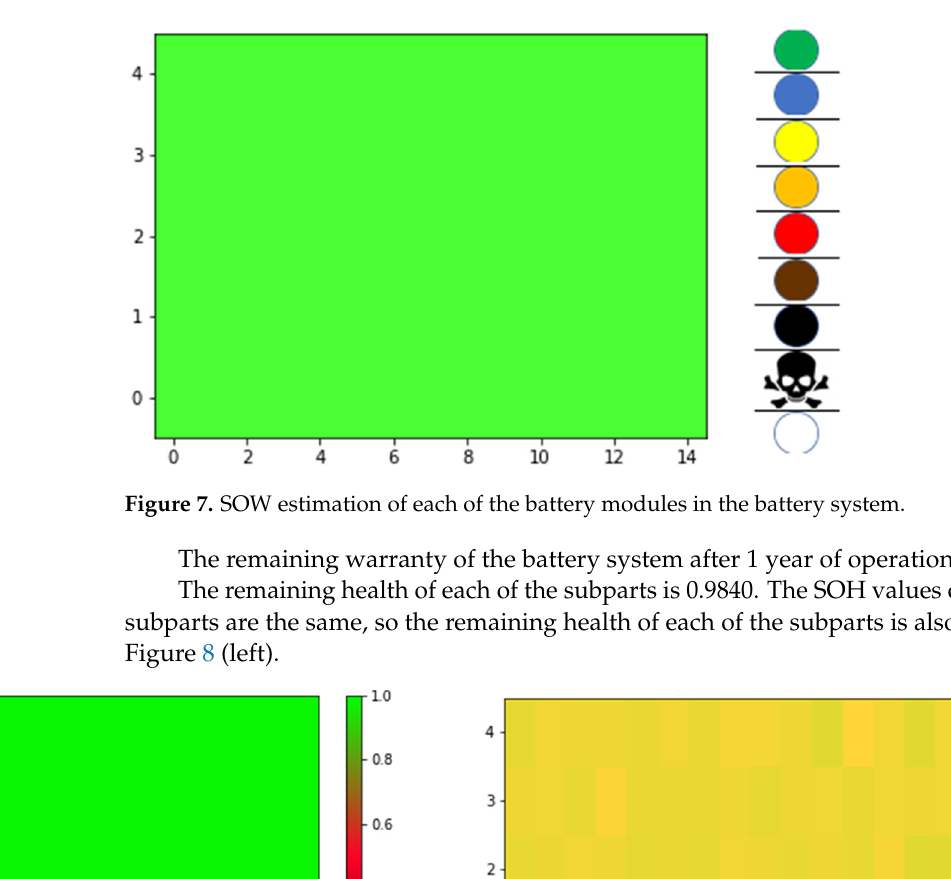
Figure 8. Remaining warranty ( left ) and remaining health ( right ) of each of the battery modules in the battery system.